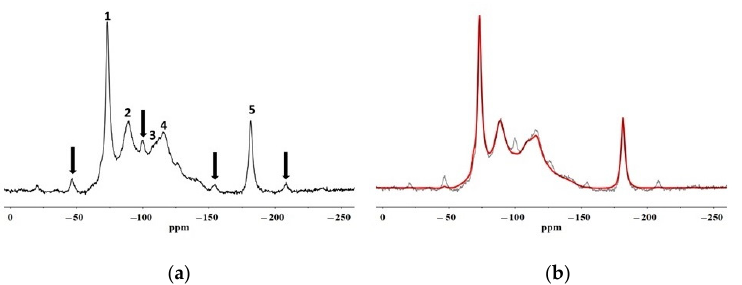
Figure 13. 19 F MAS NMR spectrum of ( a ) Fluoline HY on stone and ( b ) overlapping with the Fluoline HY film spectrum (red line). The symbol ( ↓ ) represents the spinning side bands.